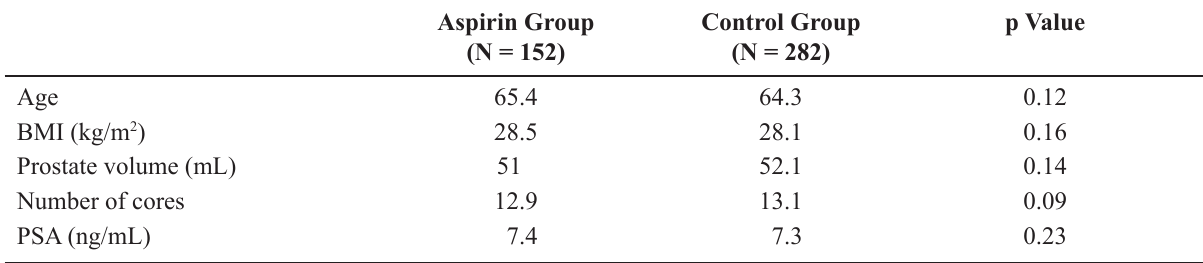
BMI = body mass index; PSA =prostate specific antigen.